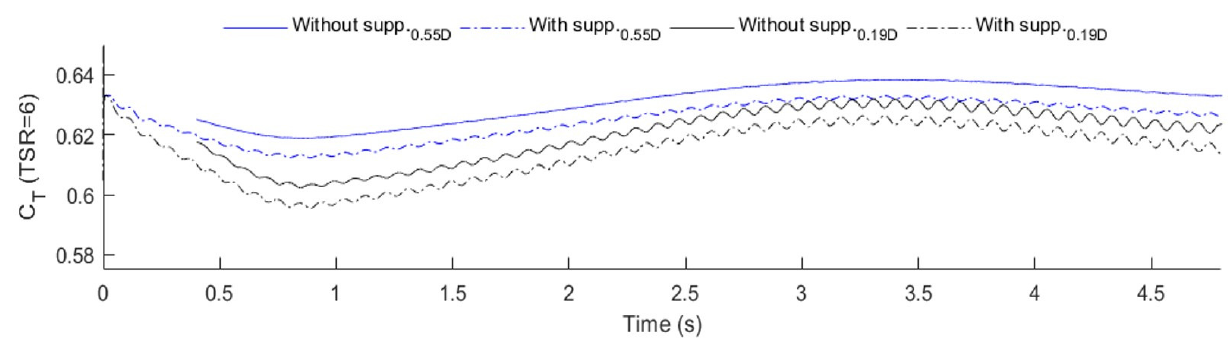
Figure 7. Time history of thrust coefficient for deep and shallow tip immersions, with and without support structure. Results are for λ = 6.